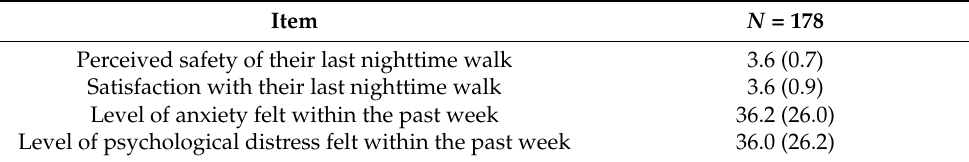
Table 3. Participants’ perceptions of their nighttime walk and their psychological